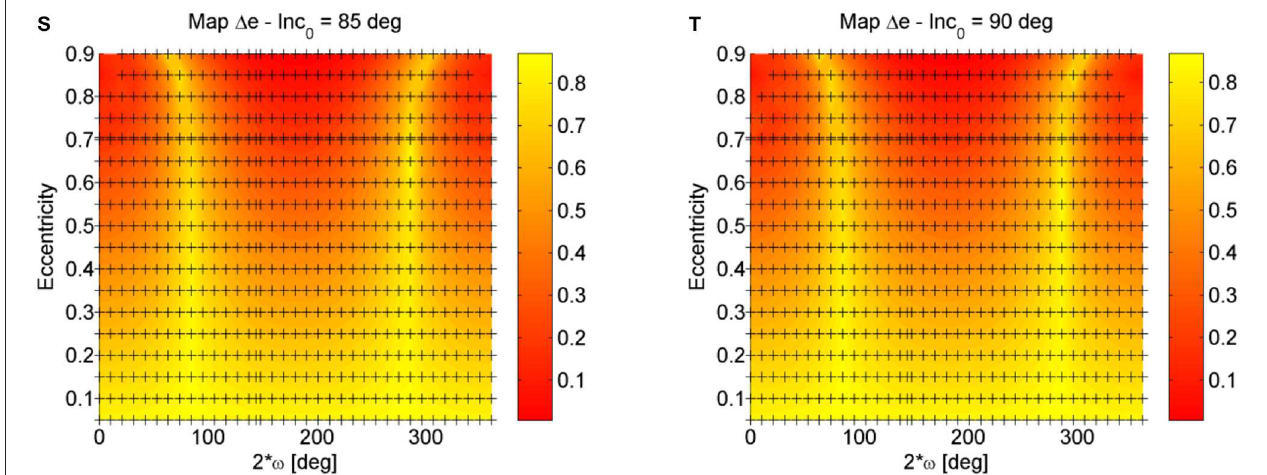
0.5deg. = 25deg. (G) Initial = 50deg. (L) Initial = 70deg. (Q) Initial =